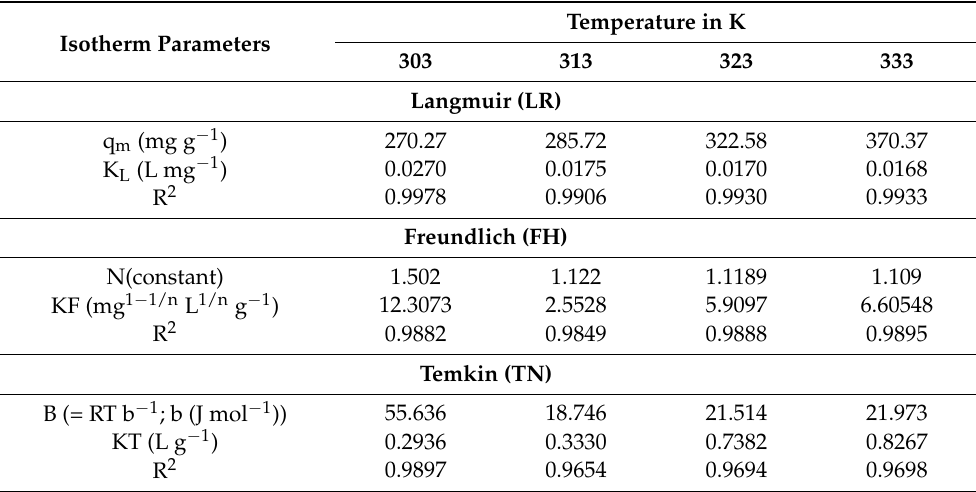
Table 3. Isotherm parameters for the adsorption of CV onto AISD (experimental conditions: adsorbent